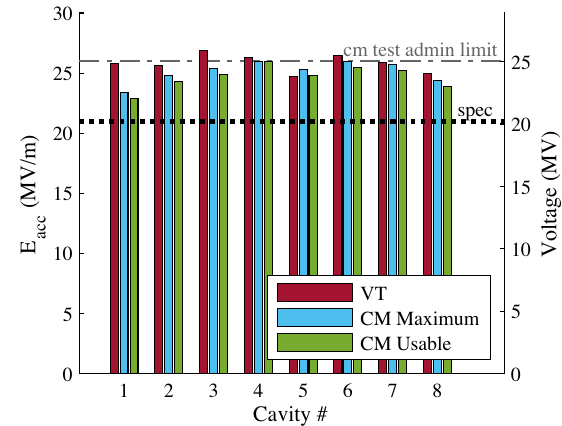
FIG. 11. VT maximum gradient, cryomodule maximum gra- dient, and cryomodule usable gradient for each cavity in the vCM. The uncertainty in the gradient measurements is approx- imately 10%.